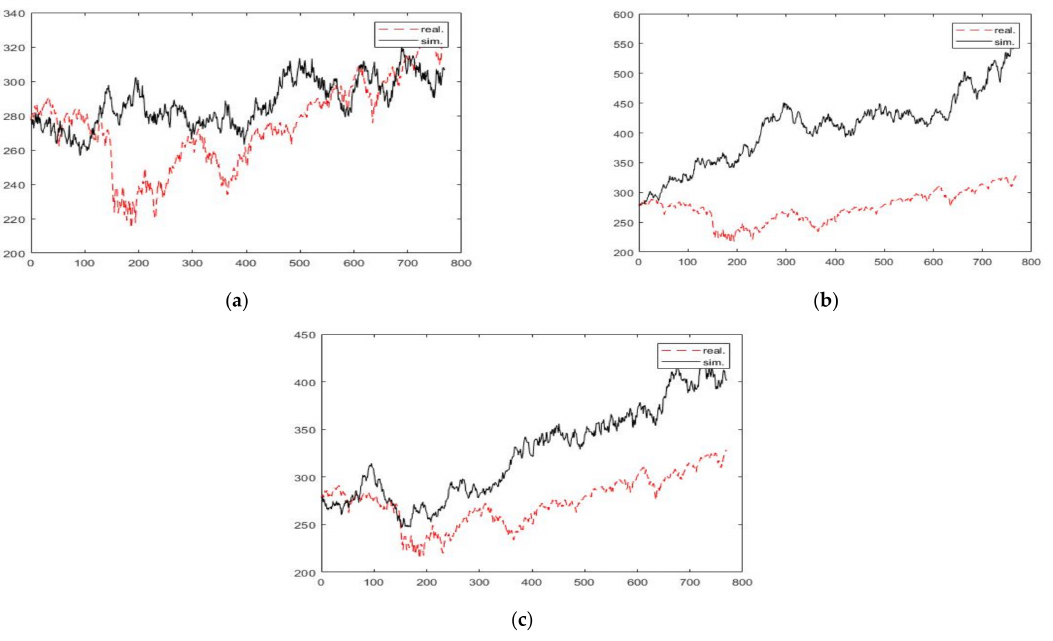
Figure 5. Simulation results using GBM (3-year period): ( a ) Hurst PE, ( b ) Hurst RS, ( c ) Hurst 0.5.